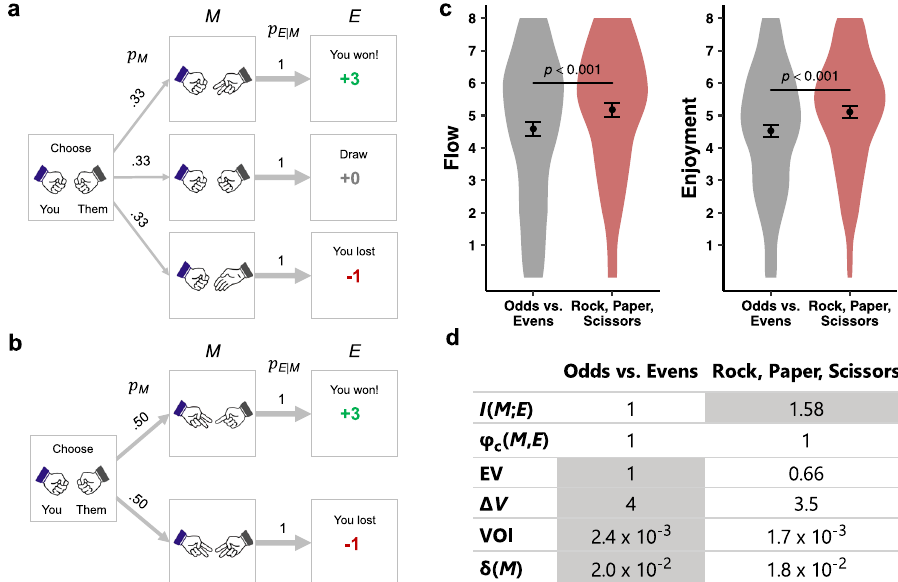
Fig. 9 Design and results of experiment 5. a Schematic of Rock, Paper, Scissors. On each trial, participants choose one of three symbols (rock, paper, or scissors), then transition to one of three states depending on their (computer) opponent ’ s symbol (rock, paper, or scissors) with a 33% chance of each state. Depending on the combination of symbols, the end state is a win (worth 3 cents), draw (worth 0 cents), or loss (worth -1 cent). We have illustrated the game with the example choice of “ rock ” for the participant. b Schematic of Odds vs. Evens. Participants fi rst chose to represent “ odds ” or “ evens ” for the duration of the game. On each trial, participants select a number (one or two), then transition to one of two states depending on the number selected by their (computer) opponent (one or two), with a 50% chance of each state. If the sum of the numbers is odd, participants advance to an end state of “ win ” (worth 3 cents) if they represent “ odds ”— otherwise they advance to an end state of “ lose ” (worth -1 cents). If the sum of the numbers if even, participants advance to an end state of “ win ” if they represent “ evens ”— otherwise they advance to an end state of “ lose. ” We have illustrated the game for the example choice of two for a participant who represents “ odds. ” c Effects of game on fl ow and enjoyment. Points denote means, and error bars represent 95% CIs. Statistics are derived from LMMs (two-sided) performed over 794 observations across 397 participants. No corrections for multiple comparisons were applied. d Key statistics associated with each game. The values of I ð M ; E Þ , expected value (EV), marginal value ( Δ V ), and the correlation between M and E ð φ ð M ; E ÞÞ were computed analytically. The values for temporal difference prediction error ( δ M ð Þ ) and value of information (VOI) correspond to the c average output of 1,000 simulations. The largest value of each variable is highlighted in